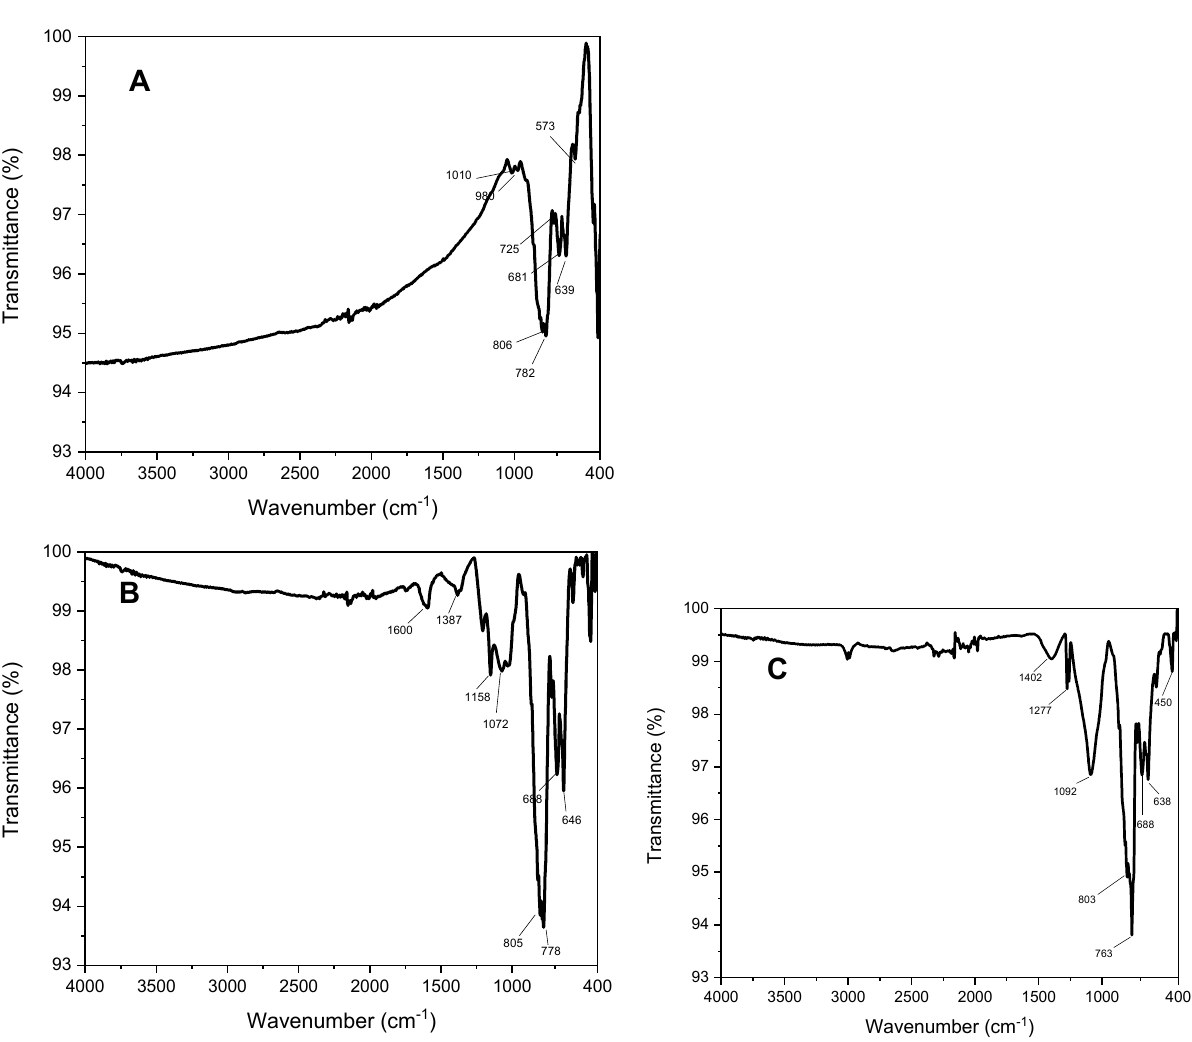
Figure 2 . SEM EDX analyses of catalysts 1 ( A ) before catalytic reactions, ( B ) after the fourth cycle, and ( C ) after the fourth cycle and thermal treatment (400°C) .